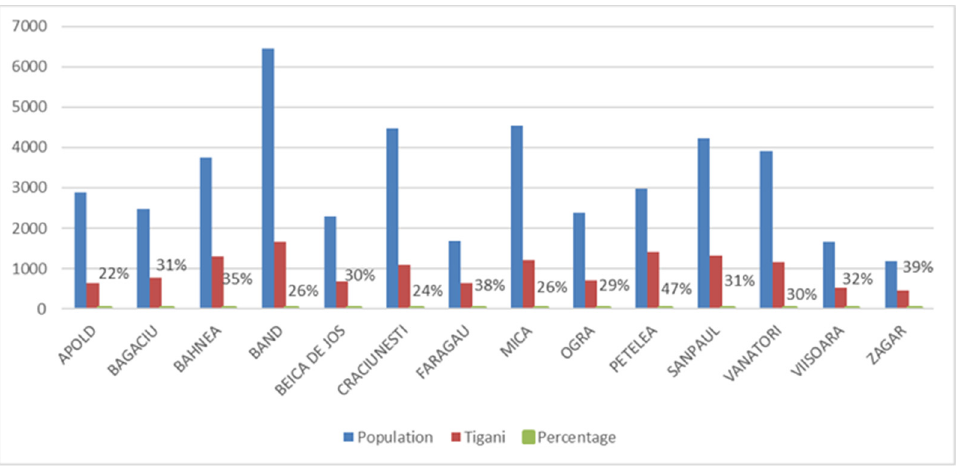
Figure 3. Mure ș County villages with more that 25% of Ț igani population. Figure 3. Mures County villages with more that 25% of T ,